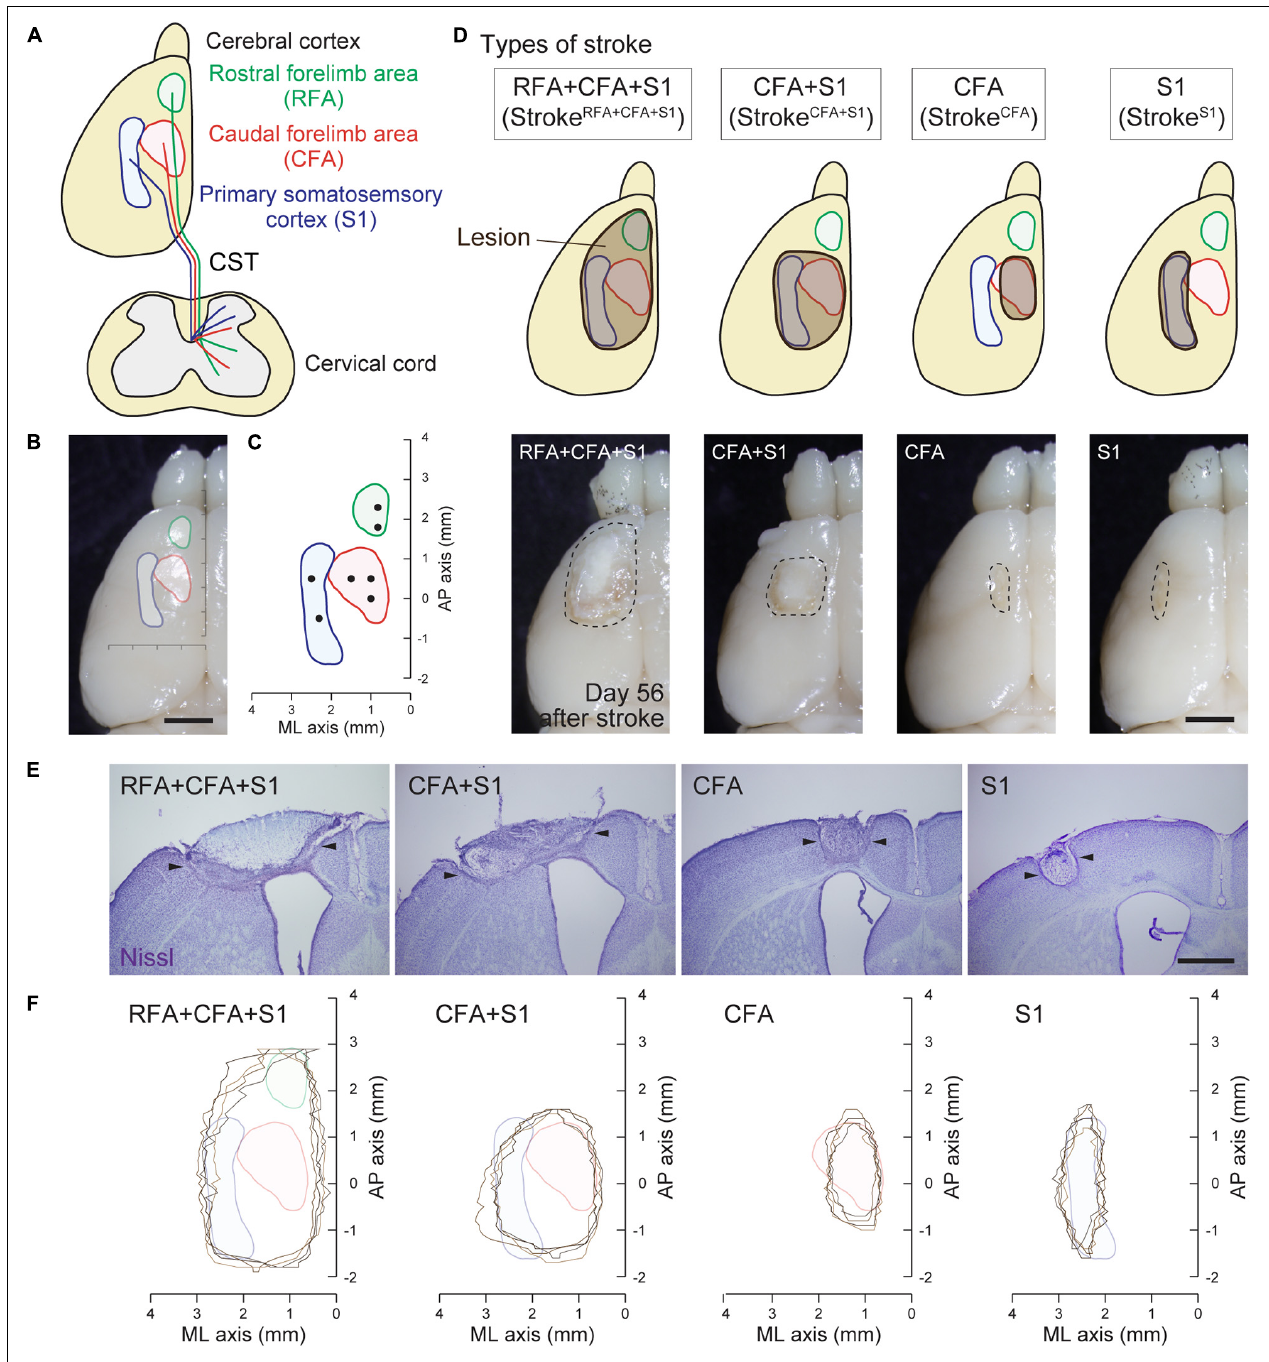
FIGURE 1 | Mouse cortical stroke models in specific sensorimotor regions. (A) Projections of different CST pathways from the motor (RFA and CFA; green and red, respectively) and sensory cortex (S1; blue) to the cervical spinal cord. Top and transverse view of the cortex and cervical spinal cord, respectively. (B,C) Cortical maps showing the areas of RFA, CFA, and S1 with a dorsal view of the cerebral cortex (B) and AP–ML coordinates (C) . Black dots in C indicate the injection sites of anterograde tracer BDA in this study. (D) Four different cortical stroke models (stroke RFA + CFA + S 1 , stroke CFA + S 1 , stroke CFA , and stroke S 1 ). Upper panels; schema of dorsal views of the cerebral cortices displaying the lesion site (brown) and the motor and sensory area. Note that the exact lesion areas are demonstrated in F . Lower panels; representative images of stroke lesions at day 56 after injury. The lesion areas are surrounded by dotted lines. (E) Representative images of the cerebral cortices of stroke models with Nissl staining in coronal sections. Arrowheads represent the lesion edges in layer V. (F) Horizontal maps showing the cortical lesion area of four representative animals in each stroke model. Scale bars: 2 mm in (B,D) ; 1 mm in (E) .